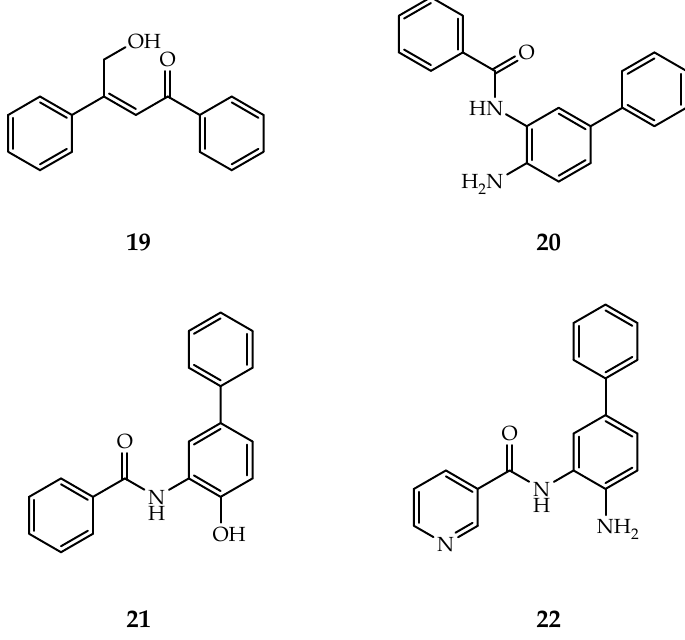
Figure 7. Selective inhibitors of HDAC1/2.